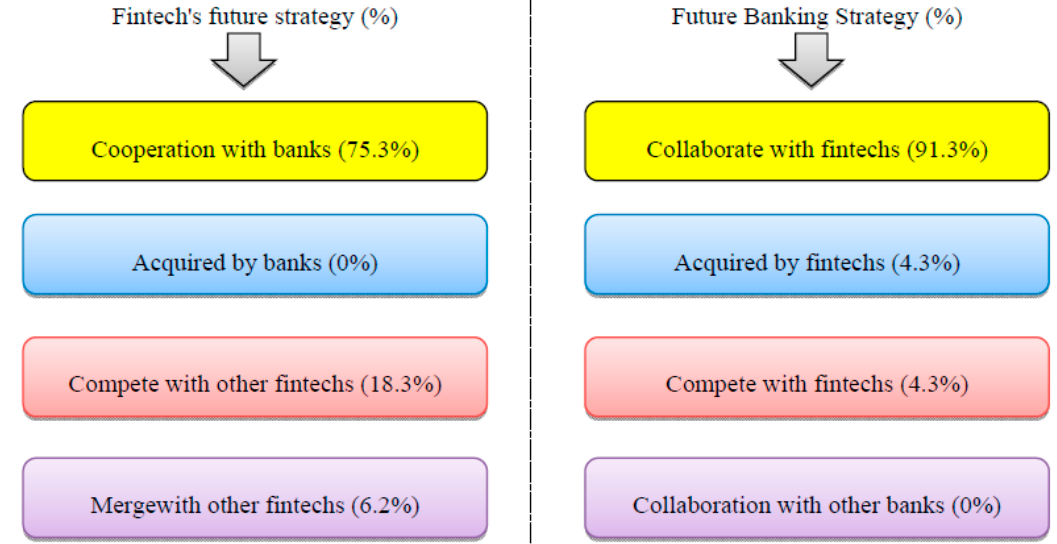
Figure 6. The future strategy of banks and financial technology (FinTech). Source: Capgemini Financial Services Analysis (Capgemini 2017a).